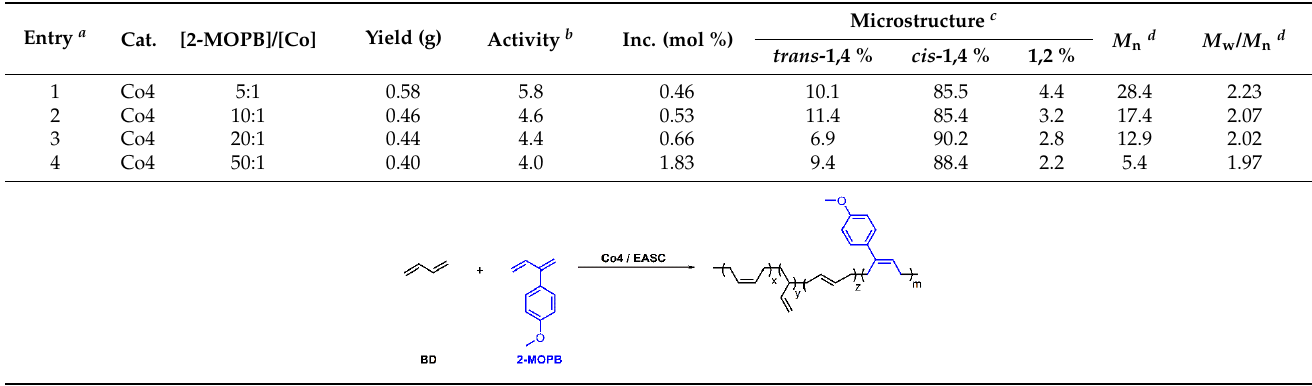
Table 2. The copolymerization of 2-MOPB with BD using Co4 .